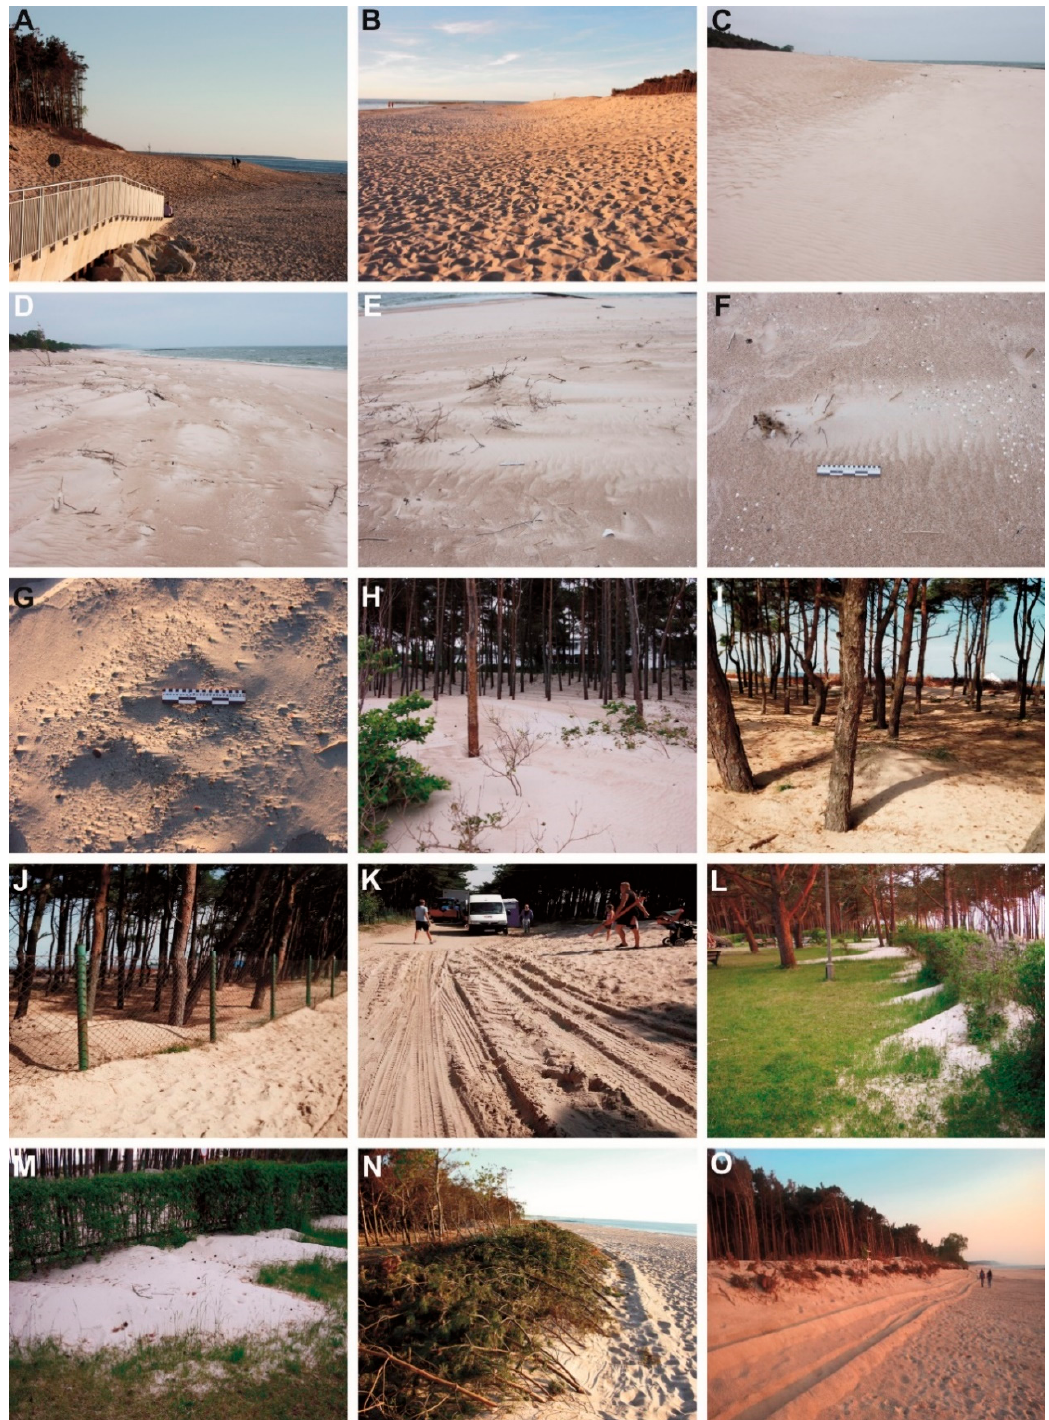
Figure 6. Morphology of the analyzed section of the beach and its surroundings (photographs taken on 27–28 May 2017). A – C —new beach, D – F —aeolian shadows, F – G —pavement, made of coarse sand and shells, H – J —sand coverage and aeolian drifts and shadows behind the trees, K —sand on the road, L – M —aeolian tongues in holiday resort, N – O —branches of coniferous and deciduous trees on the border between the beach and the forest.